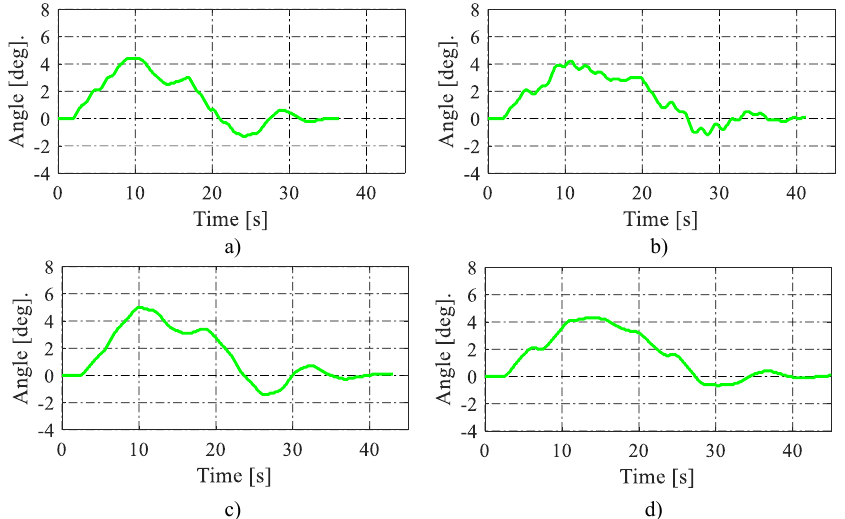
Figure 6. Analysis of the shaper design robustness against different actual cable lengths ( l cable ): ( a ) l cable = 5 m and l design = 10 m; ( b ) l cable = 5 m and l design = 15 m; ( c ) l cable = 15 m and l design = 10 m; and ( d ) l cable = 15 m and l design = 20 m.